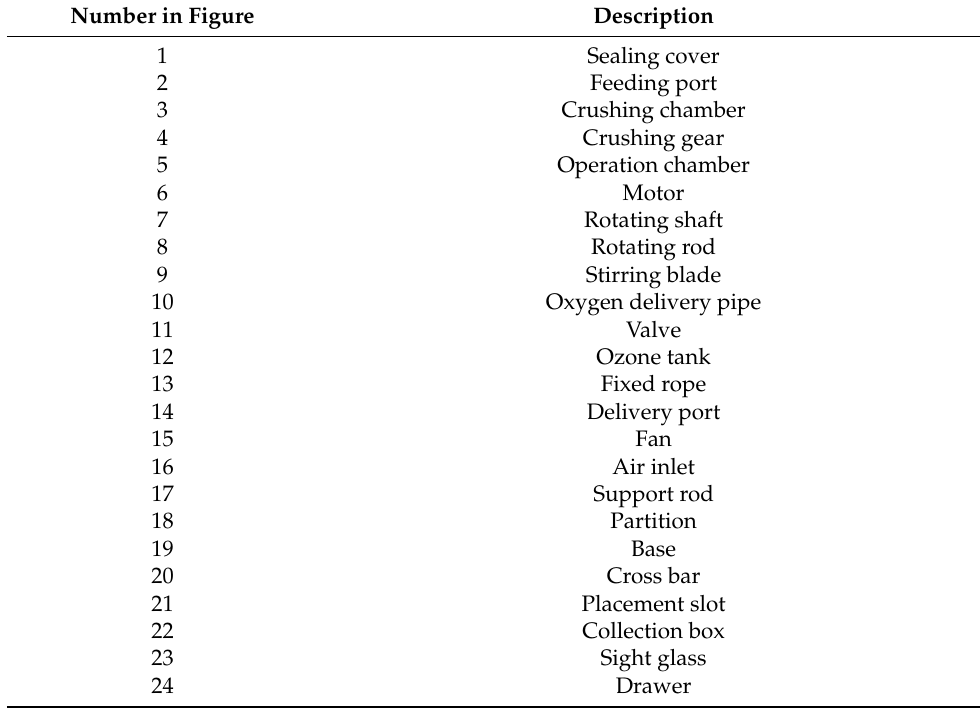
Table A8. Both aerobic and anaerobic fully automated composter from CN212954904U